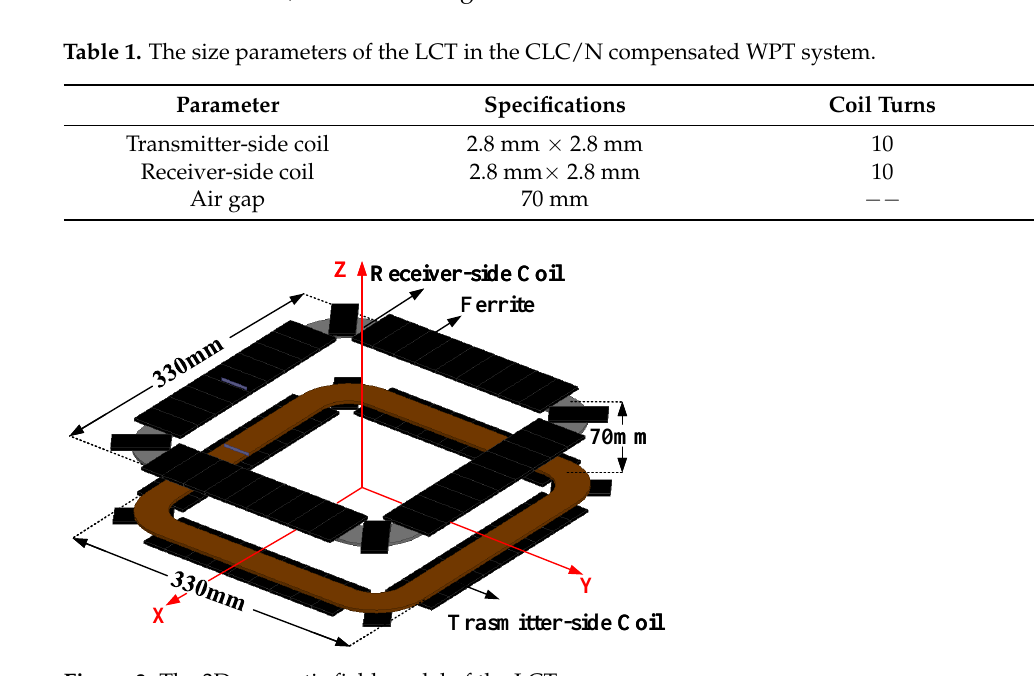
Figure 3. The 3D magnetic field model of the